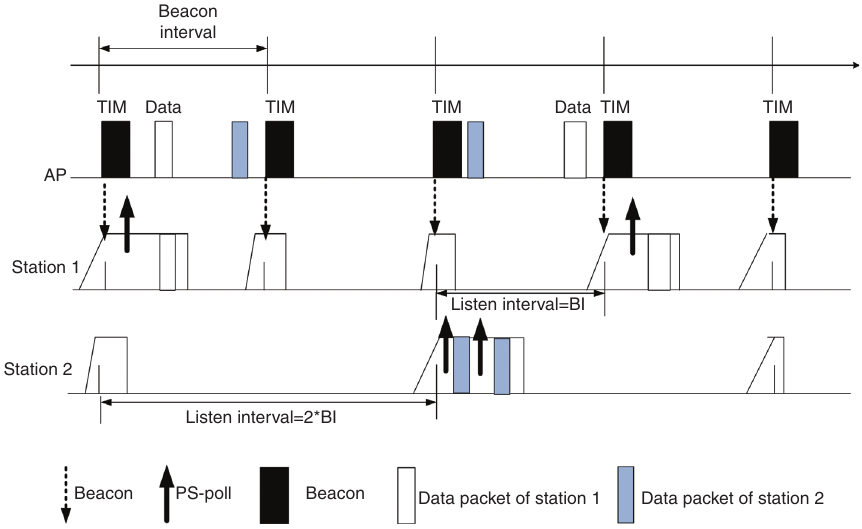
Figure 1. Packet Exchanges in the Standard